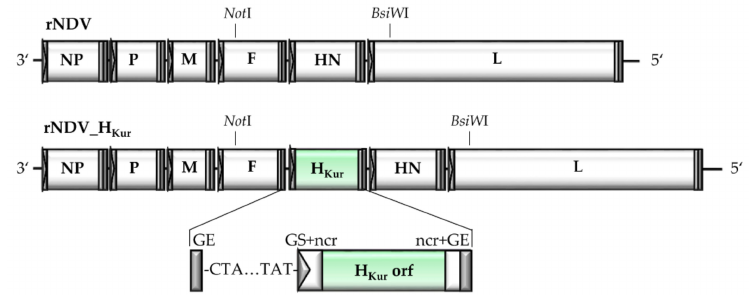
Figure 1. Construction of recombinant Newcastle disease virus (NDV) expressing peste des petits ruminants virus (PPRV) hemagglutinin (H). Schematic representation of genomic organization of parental rNDV and newly generated rNDV_H Kur expressing PPRV hemagglutinin (H). The PPRV transgene is inserted between the genes encoding the NDV fusion protein (F) and the hemagglutinin-neuraminidase (HN). The open reading frame (orf) is flanked by the gene start sequence (GS, grey triangle) and the gene end sequence (GE, grey rectangle), and as indicated by the NDV HN-non-coding regions (ncr, white rectangles). The basis of virus rescue is the full-length plasmids pNDVGu und pNDV_H Kur. The 6035 bp Not I- BsiW I fragment of pUCNDV_H Kur was inserted into pNDVGu after cleavage of the respective plasmids with Not I and BsiW I, resulting in pNDV_H